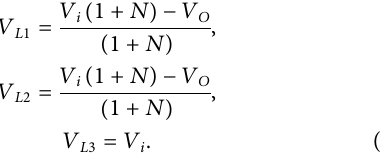
Phase difference V = 360 0 , V =120 ° (n = 3) (23). n The fl ux produced in the inductor winding is given as